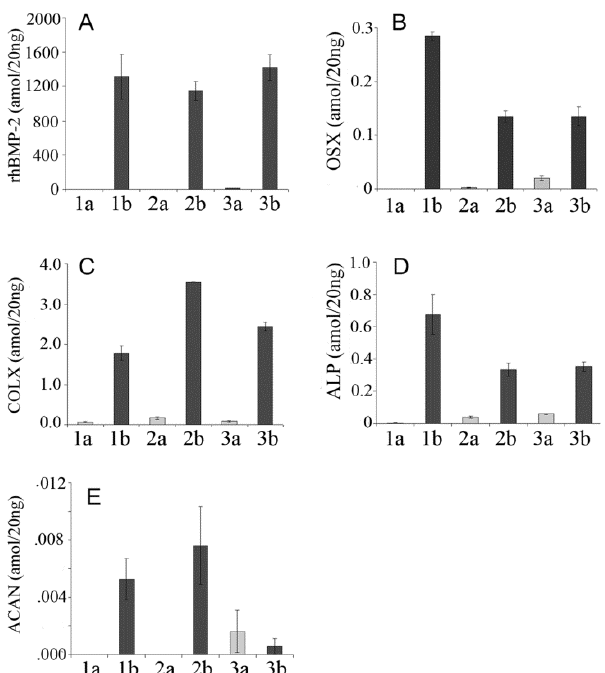
Figure 4. C9 was grown on 20 nm PB (1), 200 nm PB (2), or PSS 28 (3) in DOXY + / rhBMP2 − medium (a) or DOXY − / rhBMP2 + medium (b) for 14 days. mRNA levels determined by qRT-PCR using primers for rhBMP2 ( A ), OSX ( B ), COL-X ( C ), ALP ( D ), and ACAN ( E ).